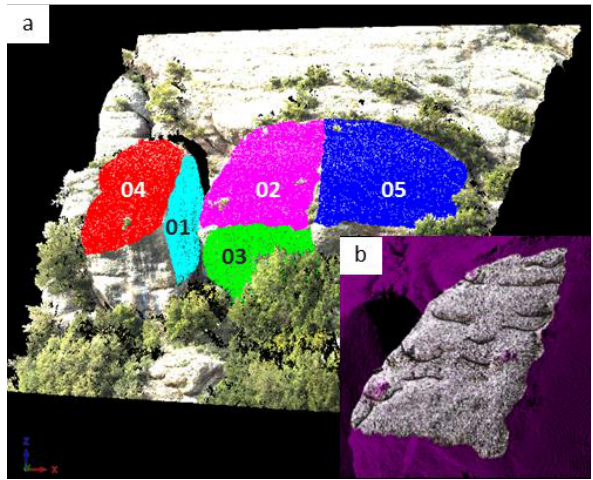
Figure 4. Designated reference planes for the studied data ex- tract (a). Close up of reference plane 02 with designated frac- tures in the weathered rock surface (b)